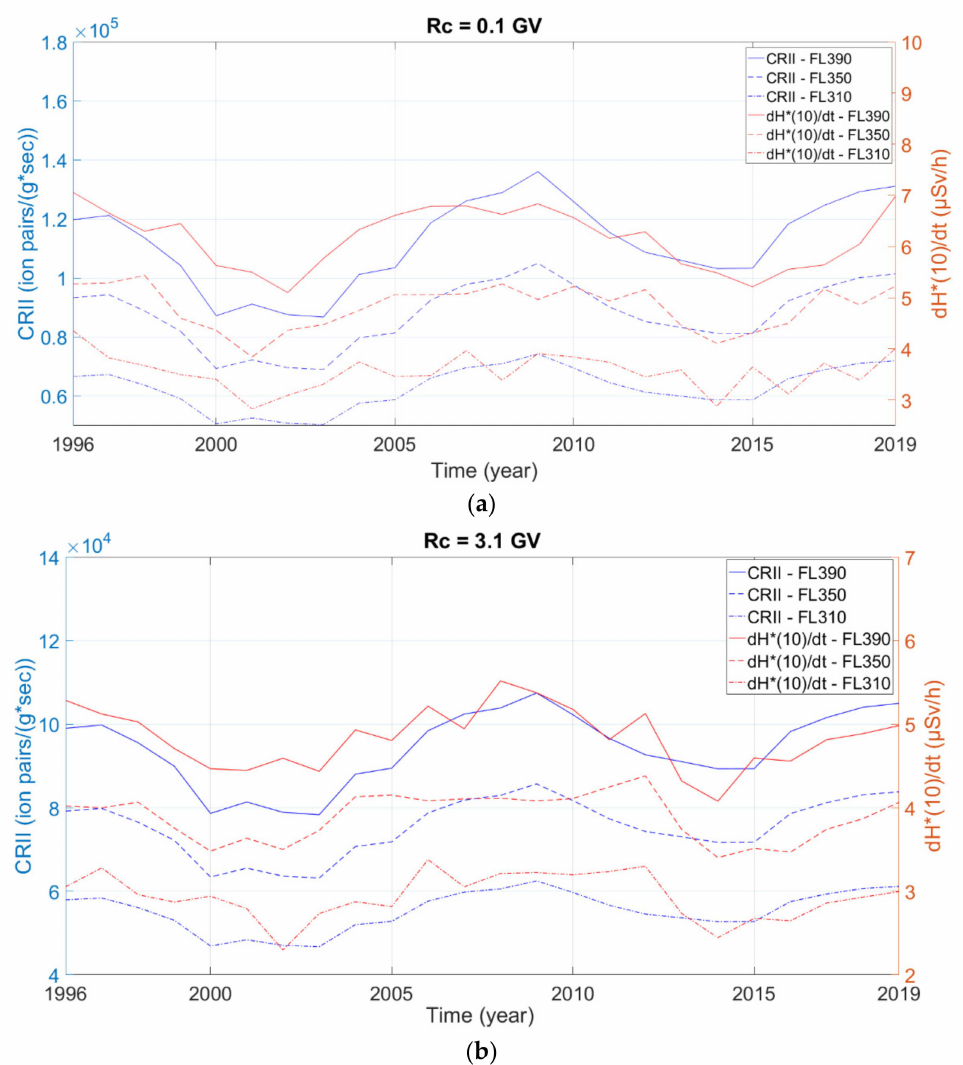
Figure 3. Yearly distribution of CRII rate (left axis, blue lines) and ambient dose equivalent rate (right axis, red lines) at three different flight levels (FL310, FL350, FL390), for the time period 1996–2019: ( a ) at a polar region with cut-off rigidity 0.1 GV; ( b ) a region with cut-off rigidity 3.1